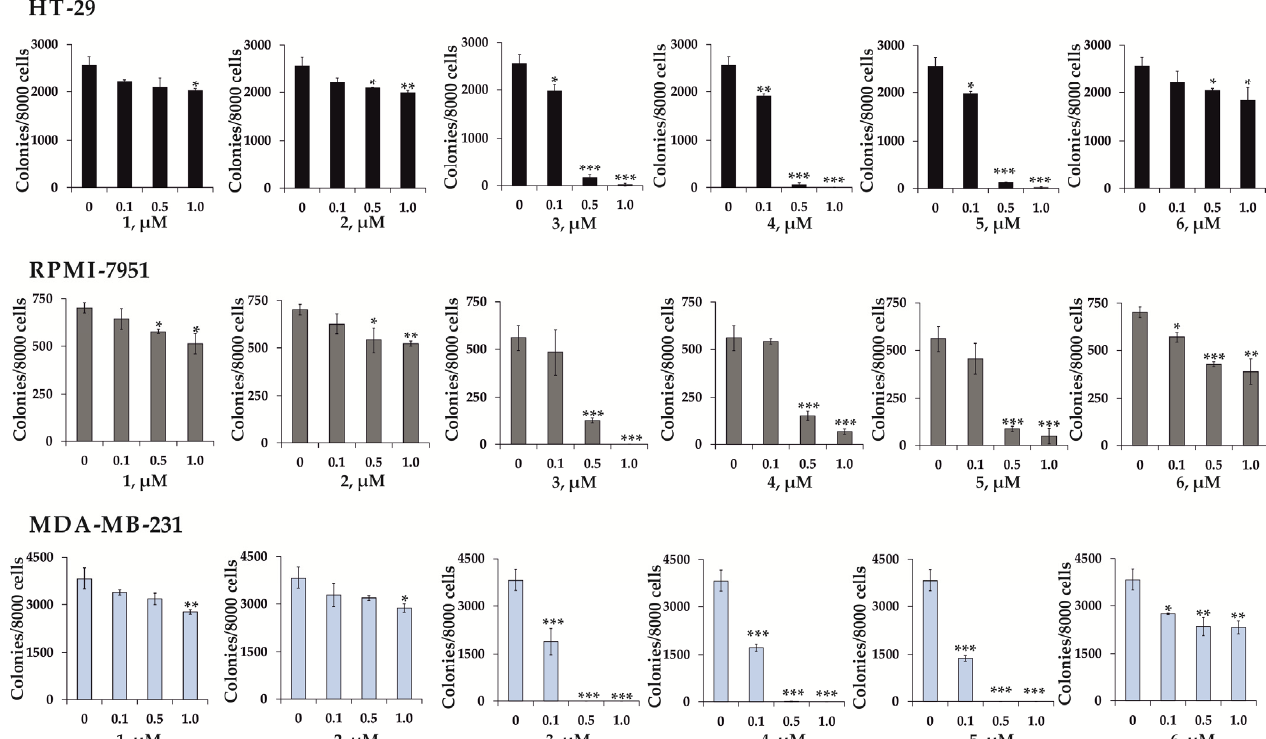
Figure 3. Effect of compounds 1–6 on colony formation of human colorectal carcinoma HT-29, melanoma RPMI-7951, and breast cancer MDA-MB-231 cell lines. HT-29, RPMI-7951, and MDA-MB-231 cells (2.4 × 10 4 /mL) treated with/without investigated 1–6 (0.1, 0.5, and 1 µM) and subjected into a soft agar. The culture was maintained at 37 °C in a 5% CO 2 atmosphere for 2 weeks. The colonies were counted under a microscope with the aid of the ImageJ software program (n = 6 for control and each compound, n—quantity of photos). The asterisks (* p < 0.05, ** p < 0.01, *** p < 0.001) indicate a significant decrease in colony formation in cells treated with compounds compared with the nontreated cells (control).